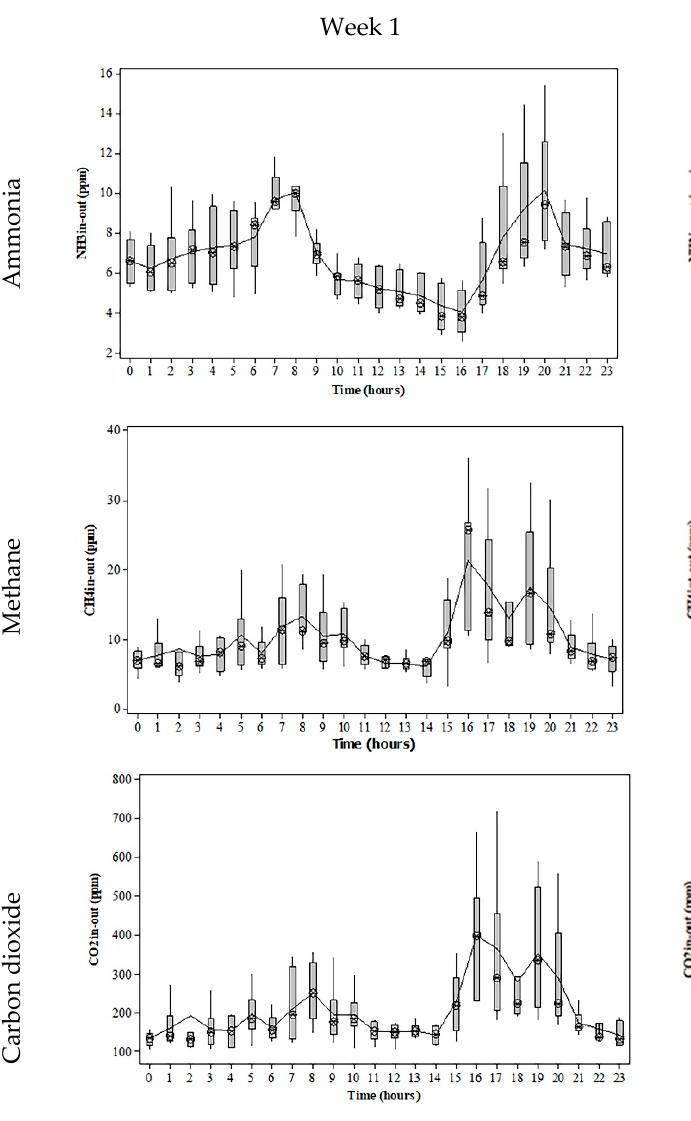
Figure 2. Daily trend of NH 3 and CH 4 emissions during W1 and W2.